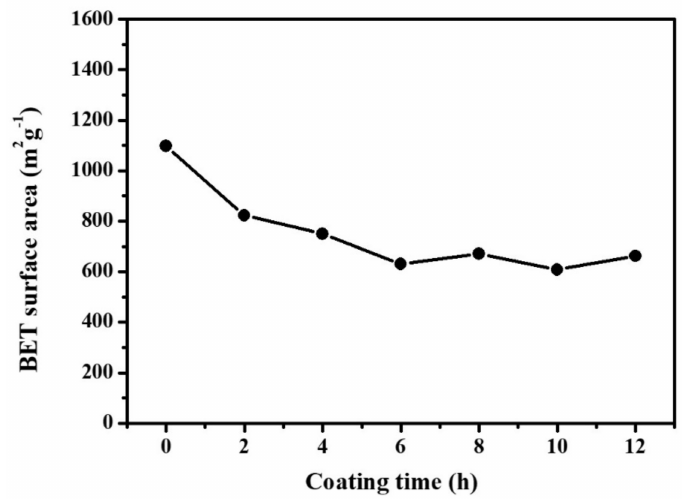
Figure 6. Brunauer–Emmett–Teller (BET) surface area of the pristine activated carbon fibers (ACF) and ACF@polydopamine-cupric oxide (PD-CuO) with di ff erent coating